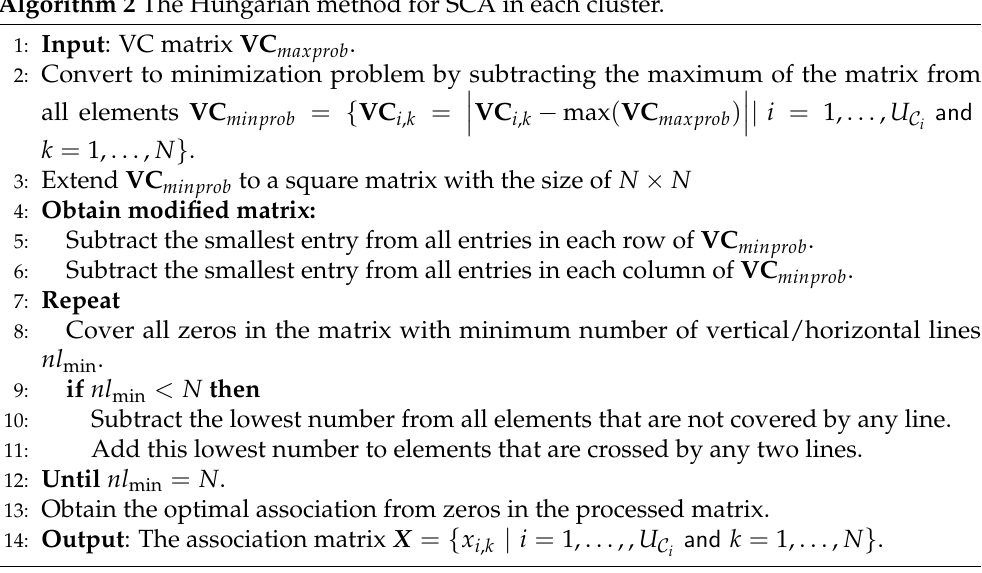
Algorithm 2 The Hungarian method for SCA in each